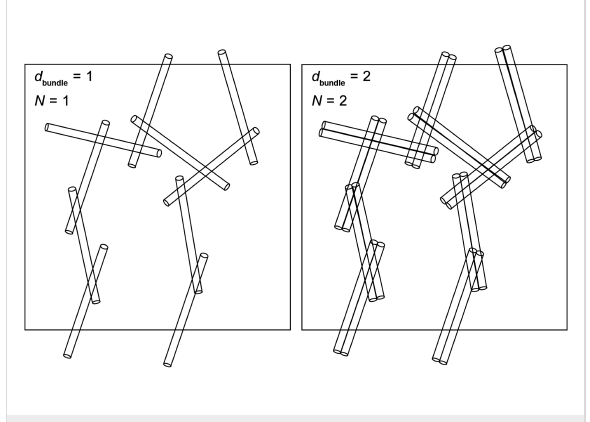
Figure 8: An illustration to clarify how the total concentration of carbon depends on bundle diameter for a given network morphology. Note that the number of bundle–bundle junctions is equal in both